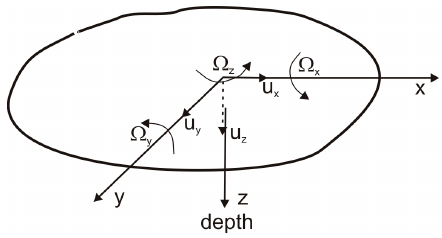
Figure 1. Sketch showing translational and rotational directions on the ground surface.